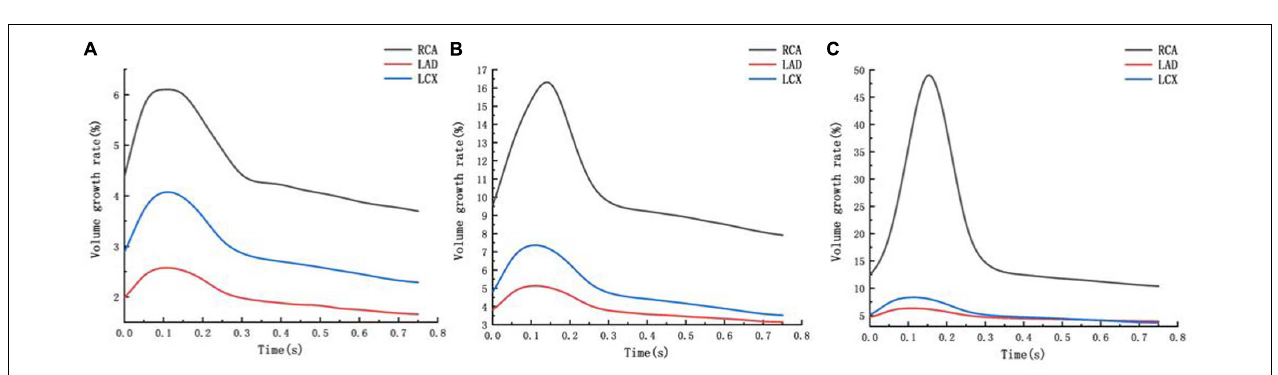
the LCX, which respectively were 0.027 − 0.221 s, 0.052 − 0.22 s, and 0.033 − 0.212